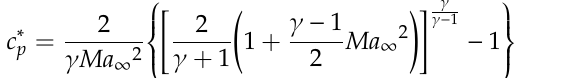
Figure 14. Pressure gradients on the upper surfaces of two airfoils ( Ma = 0.73, Re = 6.5 × 10 6 , C L = 0.800).